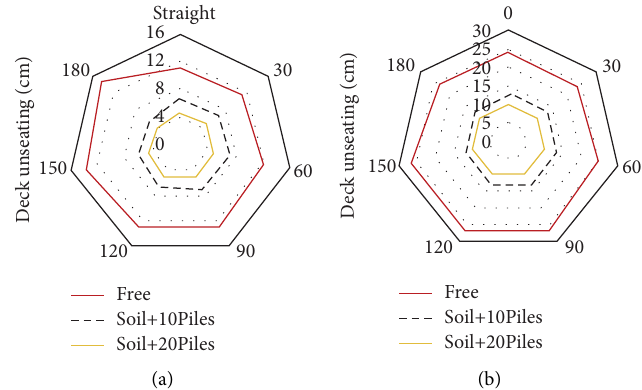
Figure 21: Abutment displacement in all bridge confgurations in the tangential direction using GMs compatible to (a) DBE and (b) MCE response spectrums.